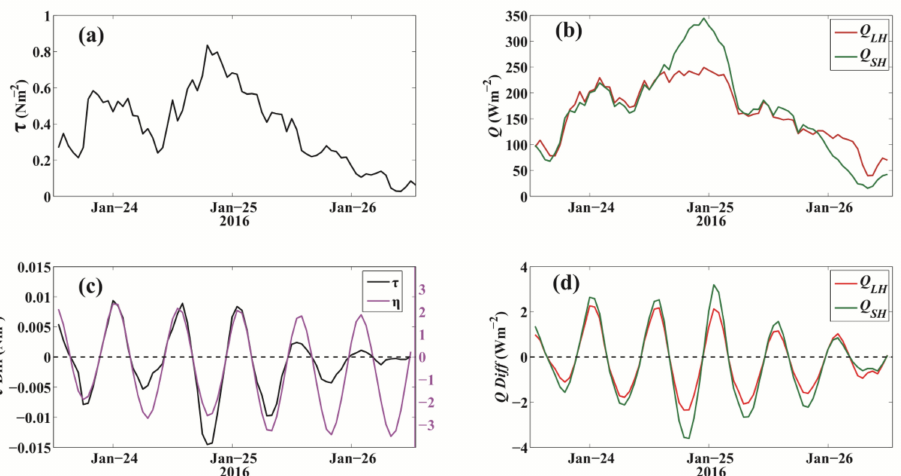
Figure 12. The wind stress (Nm − 2 , ( a )) and turbulent heat fluxes (Wm − 2 , ( b )) during the cold-air outbreak at the end of January 2016. ( c ): Wind stress differences (left y-axis) with variations in the magnitude of SSE (magenta, right y-axis) during cold-air outbreaks. ( d ) is the same as ( c ) but for Q LH (red, unit: Wm − 2 ) and Q SH (green, unit: Wm − 2